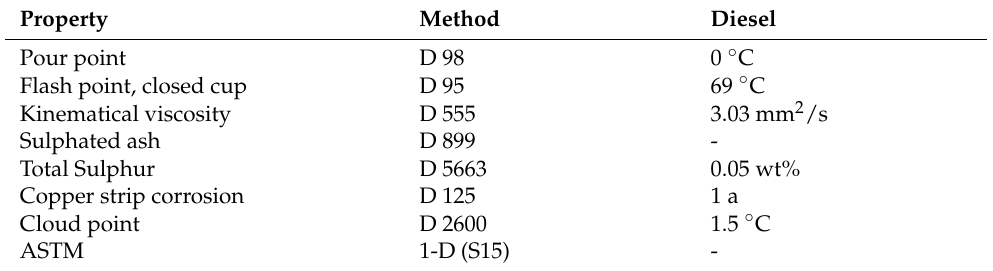
Table 2. Specifications of diesel fuels.